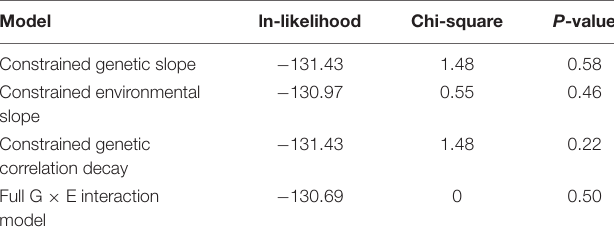
TABLE 4 | Testing the critical parameters of the full G × E interaction model for CAP. Model